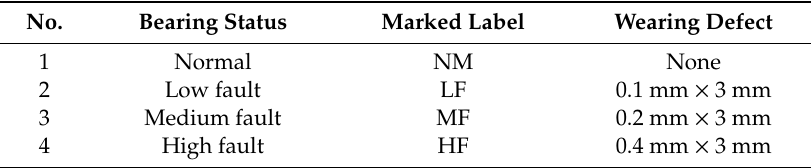
Table 3. Details for the experimental bearings.